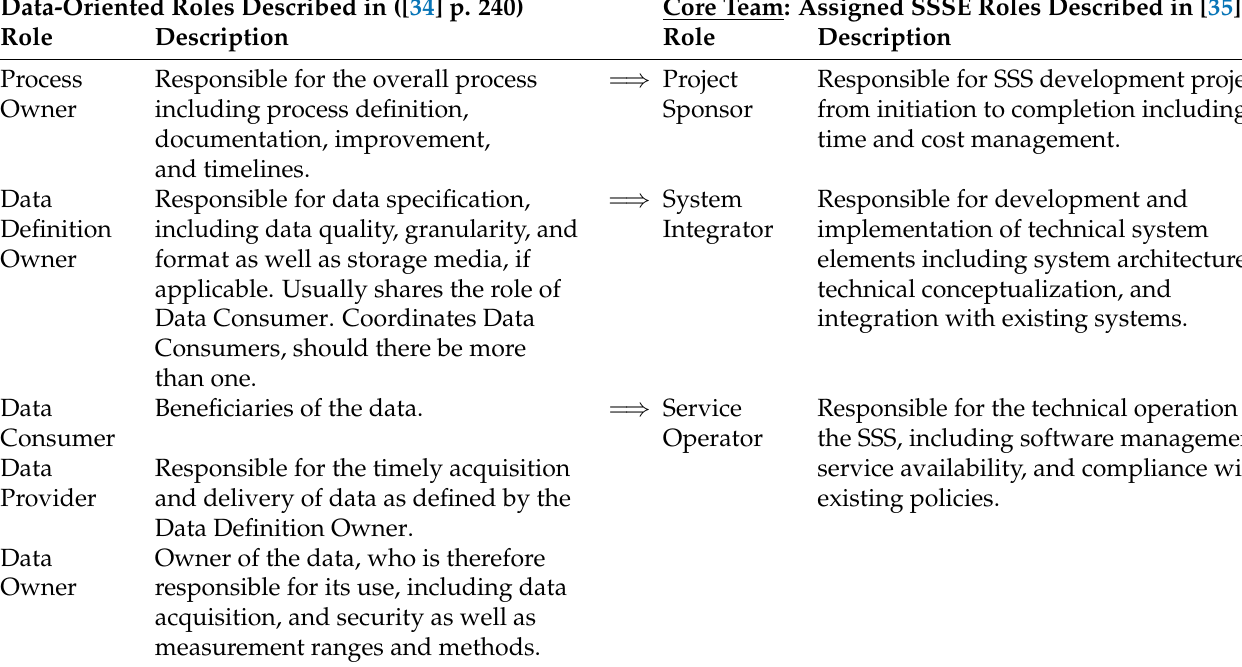
Table 1. Mapping of data-oriented roles to the SSSE roles that make up the Core Team for realizing the SemDaServ approach. Data-Oriented Roles Described in ([34] p.